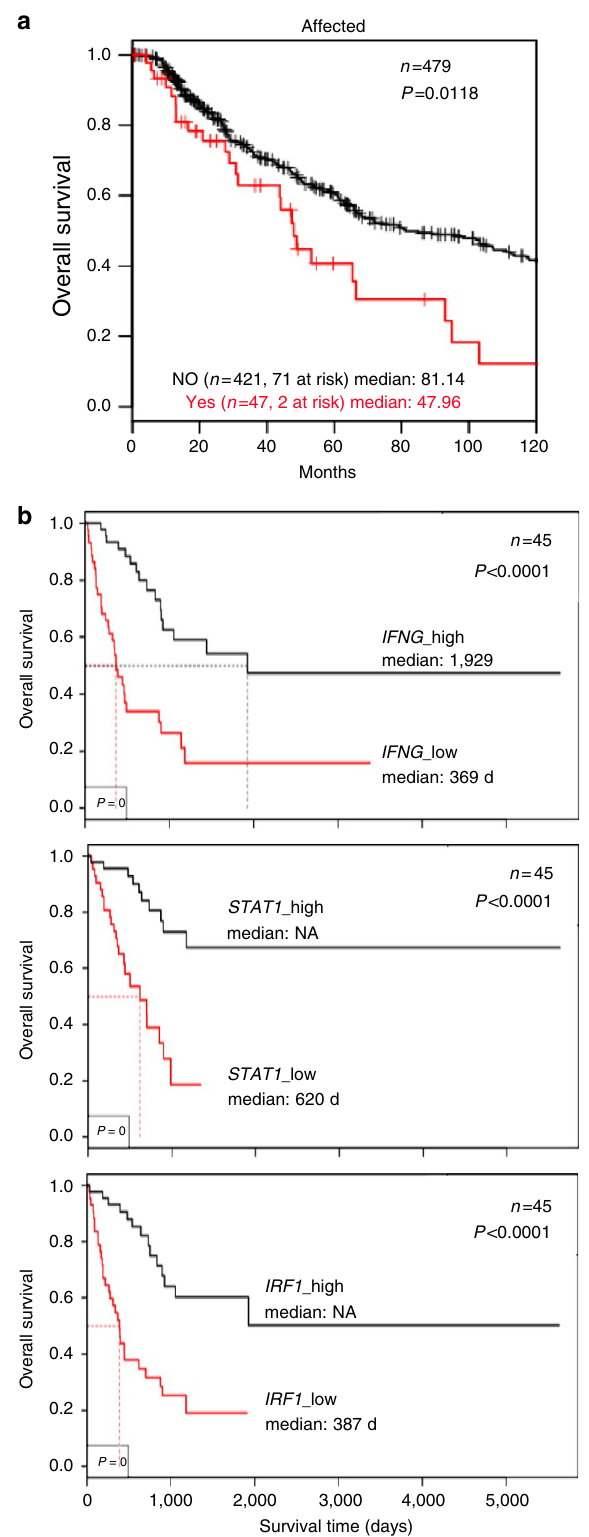
Figure 6 | Alterations in IFN c pathway signalling impact on